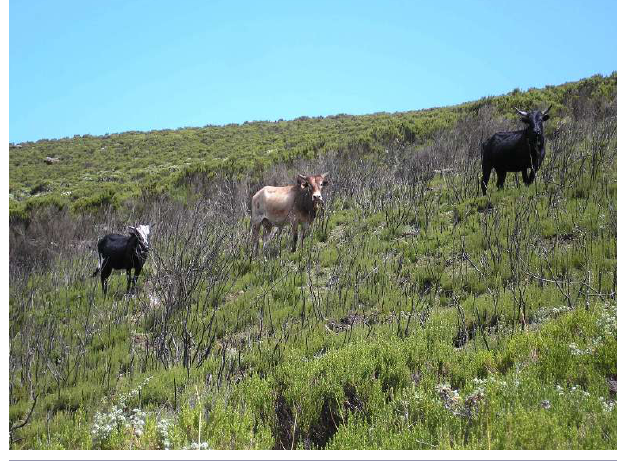
Fig. 1 . Cattle in a 1-year-old stand of Erica spp. Some of the dead Erica stems from the pre-burn stand are still standing. Older and taller Erica is seen in the